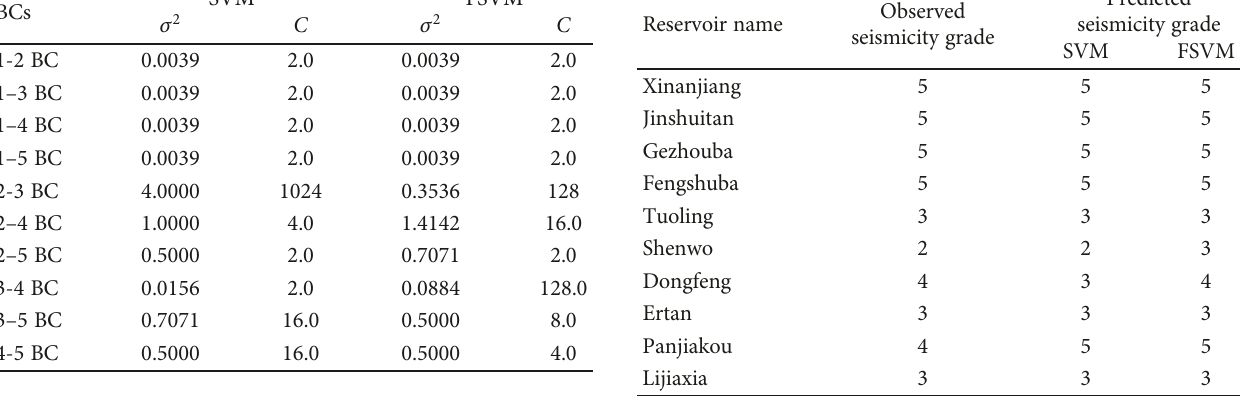
Table 11: Optimal output for respective BCs in cross validation test.